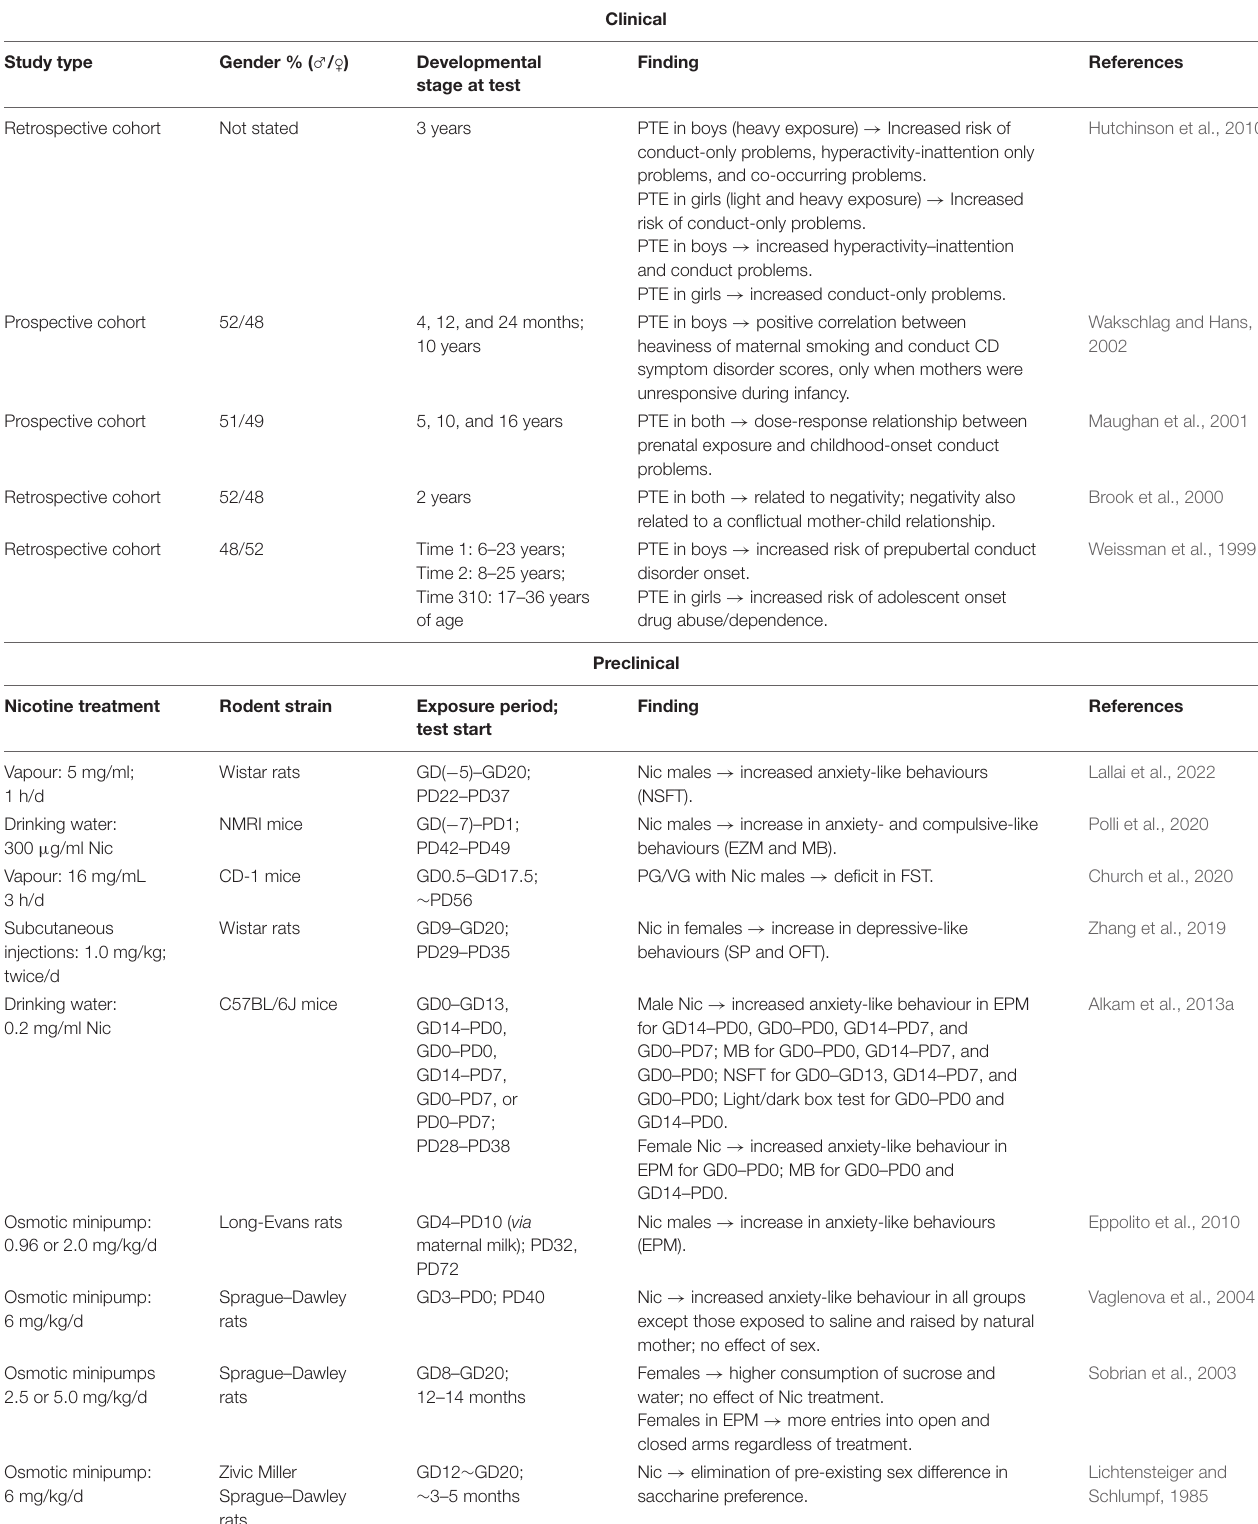
TABLE 2 | Summary of emotion/mood findings in clinical and preclinical studies.